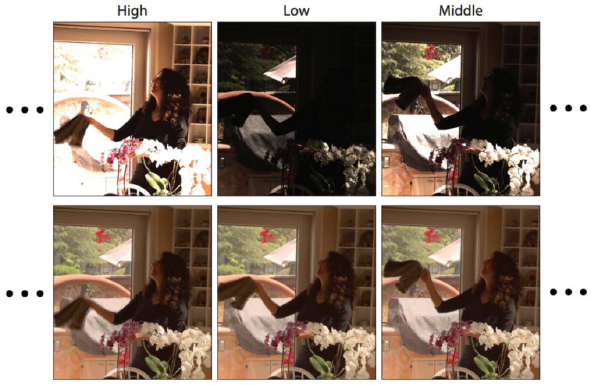
Fig. 10 High-dynamic range (HDR) video reconstruction from Kalantari et al. [58]. Top: frames recorded by a special video camera that cyclically changes exposure for each frame (between high, low, and medium exposure). Bottom: HDR reconstruction, with light and dark areas both well-exposed. Reproduced with permission from Ref. [58], c (cid:13) Association for Computing Machinery, Inc.